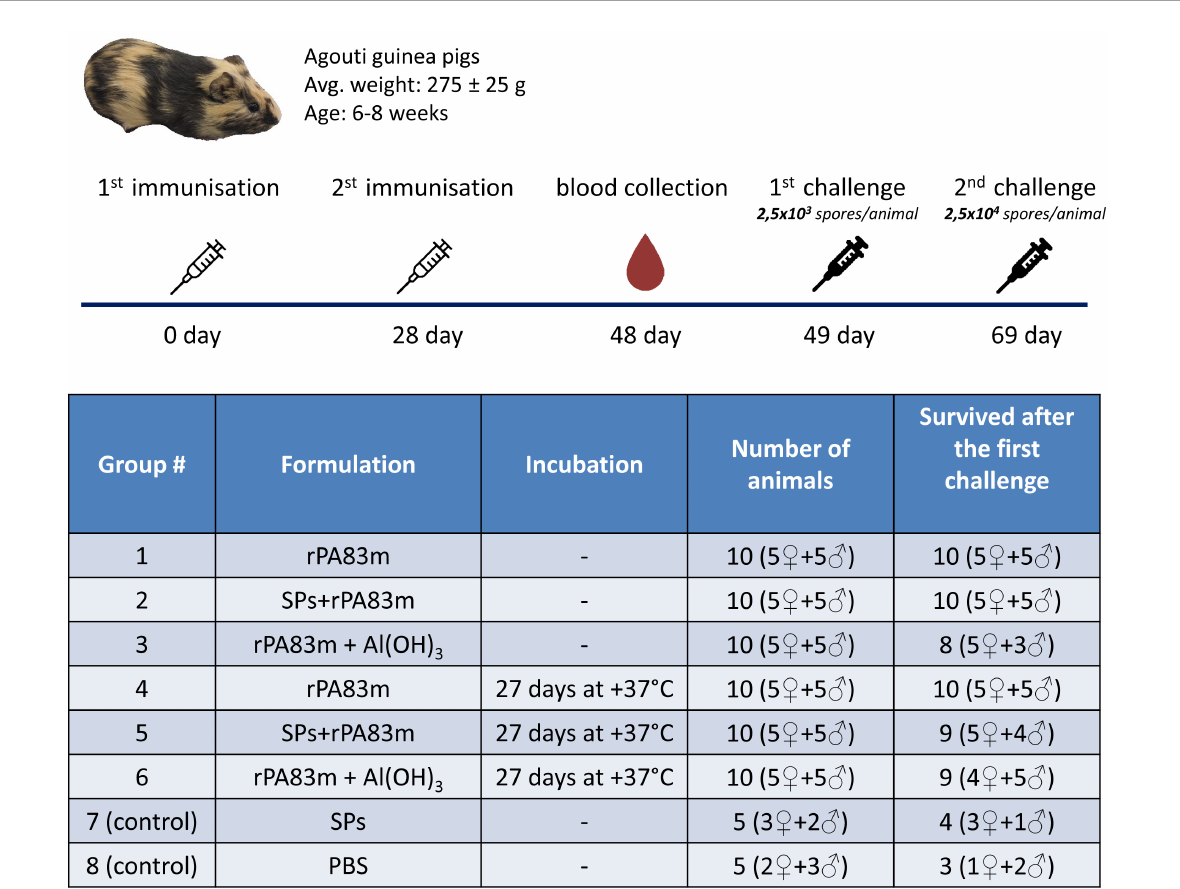
FIGURE4 Immunisation schedule and description of guinea pig groups involved in the experiment to evaluate the immunogenicity and the protectiveness of various rPA83m formulations. Groups of guinea pigs were immunised subcutaneously twice at 28-day intervals with a corresponding formulation containing 30 µ g of rPA83m. In rPA83m + SPs formulation rPA83m/SPs mass ratio was 1:10. In rPA83m + Al(OH) 3 formulation rPA83m/Al(OH) 3 mass ratio was 1:10. Animals in group 7 (control) were immunised with 300 µ g of SPs. Animals in group 8 (control) were immunised only with PBS. Incubated samples were subjected to incubation at +37 ◦ C for 27 days. All administered samples were prepared in PBS; the final volume was 0.3 ml. Blood was collected from the marginal ear vein 20 days after the second immunisation. At 21 days after the second immunisation, all guinea pigs were subcutaneously challenged with B. anthracis strain 81/1 2,500 spores per animal. At 20 days after